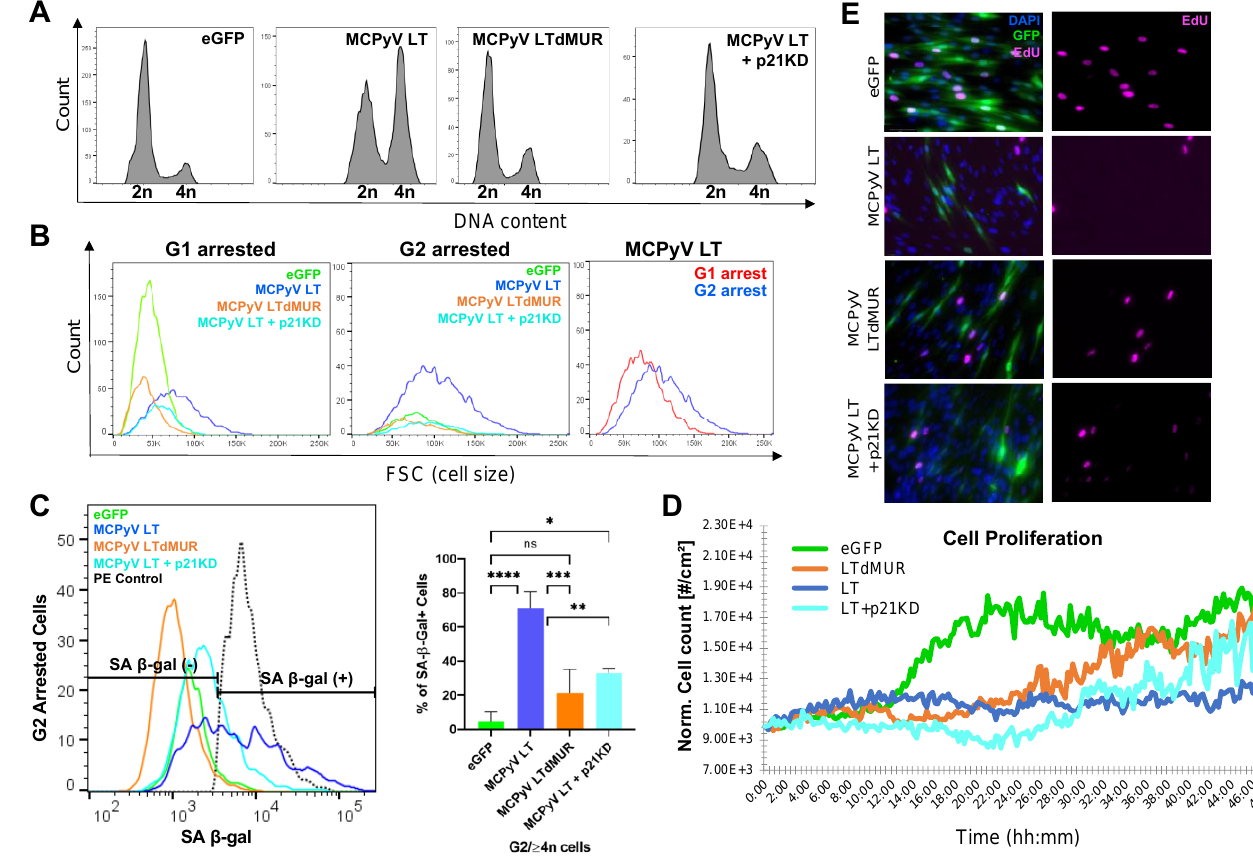
Figure 4. MCPyV LT leads to prolonged G2 cell cycle arrest. ( A ) MCPyV LT − expressing cells accumulate mainly in G2 phase. Cell cycle analysis of eGFP empty vector, MCPyV LT, MCPyV LTdMUR, and MCPyV LT + p21KD (shp21.1) using flow cytometry. Hoechst 33342 was used to stain DNA. A total of 10,000 events were analyzed for each sample, n = 3. ( B ) Histogram of forward scatter (FSC) comparisons of G1 − and G2 − arrested cells. G1 and G2 cells in MCPyV LT − expressing (GFP + ) cells were gated and analyzed for cell size using forward scatter (FSC) parameter. Cellular size of G2 − arrested cells in MCPyV LT − expressing cells is larger than G1 − arrested cells. ( C ) MCPyV LT − induced senescent cells are arrested mainly in G2. Histogram of SA − β − gal staining (PE) on G2 − arrested cells (left). Quantification of G2 − arrested/SA − β − Gal + cells by flow cytometry (right). Black dashed line represents PE positive control. Statistical significance was determined using the one − way ANOVA test (* p < 0.05, ** p < 0.01, *** p < 0.001, **** p < 0.0001, ns = not significant). Standard error bars represent mean value with standard error. A total of 10,000 events were analyzed for each sample, n = 3. ( D ) MCPyV LT restricts cell proliferation by inducing senescence. Non − invasive live cell imaging of transduced BJ − hTERT cells was conducted using a phase holographic imaging system (HoloMonitor M4) to measure cell proliferation rates. ( E ) MCPyV LT inhibits cell proliferation. Cell proliferation assay. EdU incorporation (pink) was measured by fluorescence microscopy. Scale bar = 60 µm.